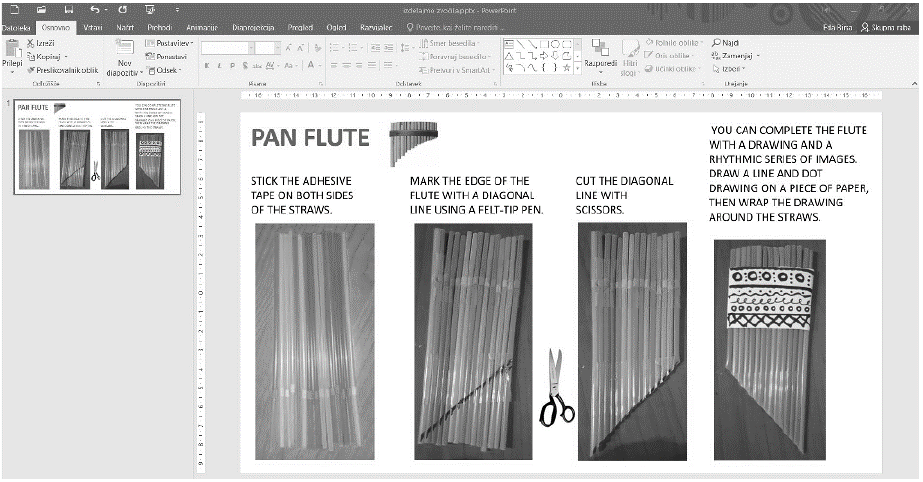
Figure 2. Using PowerPoint in the planning of a remote cross-curricular assignment for building a rattle, a lesson including both music and visual arts concepts. rattle, a lesson including both music and visual arts